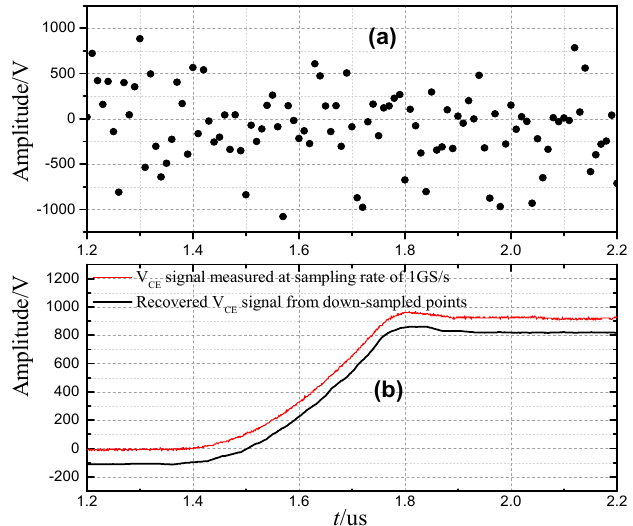
Figure 8. Reconstruction of V CE signal during IGBT turn-off transition: ( a ) random under-sampling points (100 MS/s); ( b ) comparison of the recovered V CE signal and original V CE signal.